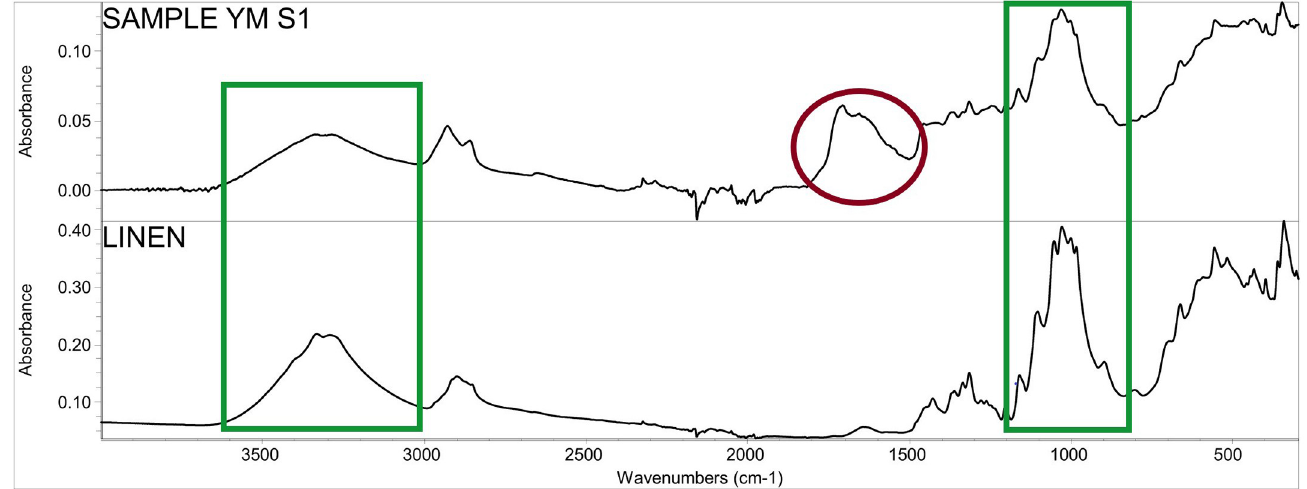
Fig 8. ATR-FT-IR spectra of textile samples from mummy (YM S1) and pure linen for comparison. Green boxes show the characteristic absorbance bands of cellulose-based fibres and the red box shows the area of spectrum that does not belong to fibres (could belong to embalming materials).